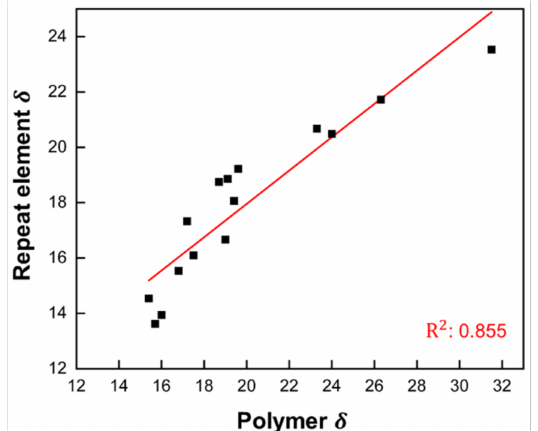
Figure 7. Correlation of Hildebrandt SP between polymers and REs. All values in MPa 1/2 . Linear fit model: δ polymer = 0.602 δ RE +